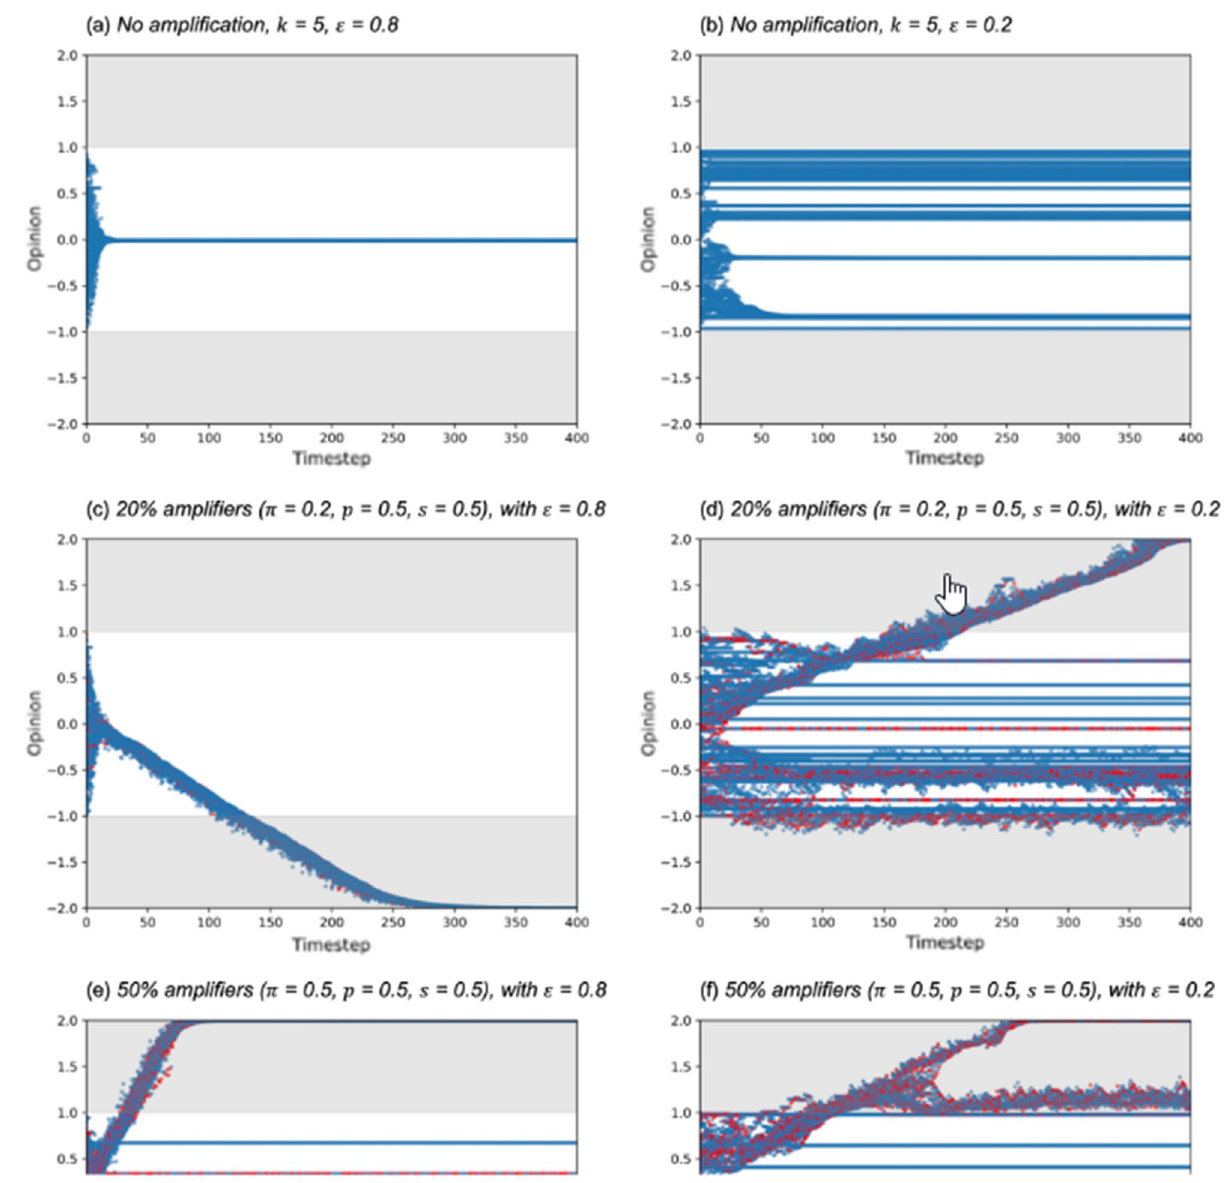
Figure 2. Opinions of individuals starting from a random distribution [− 1.0, 1.0] under a range of conditions. Red dots denote individuals who are amplifying in that timestep. Grey areas indicate opinions outside the initial opinion range. Y-axis shown from − 2.0 to 2.0 (double the initial opinion range) for clarity; in ( c ) to ( f ), opinions exceed this range and become even more